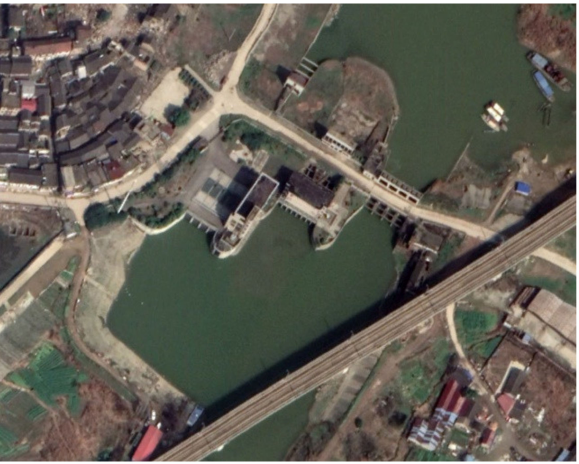
Figure 2. Satellite image of the Exi River flood discharge